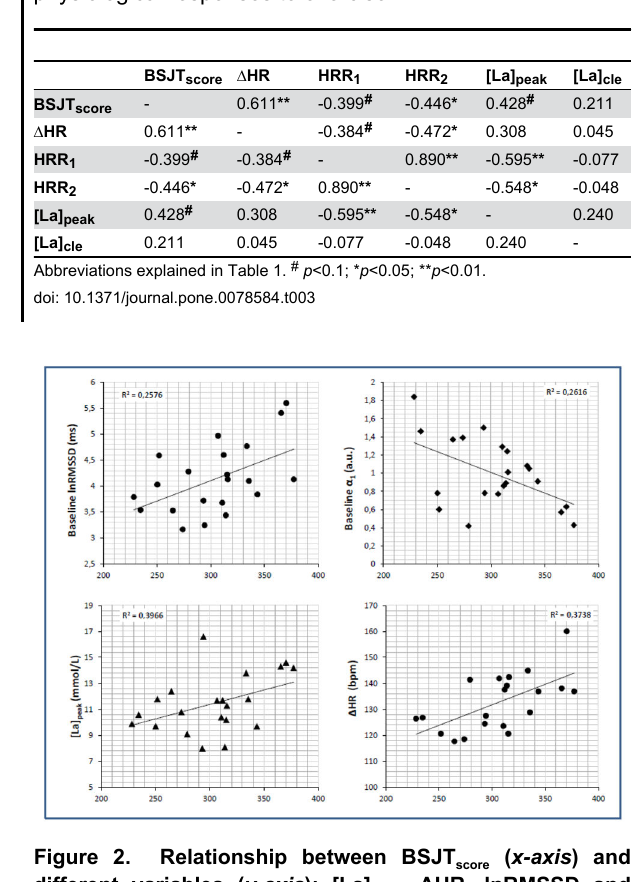
( x-axis ) and score , ΔHR, lnRMSSD and peak